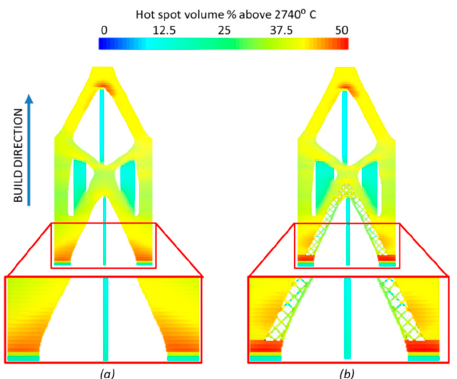
Figure 9. Comparing the hotspot observed in ( a ) the optimized domain and ( b ) the ‘X’ lattice introduced optimized domain. The inset in (a) shows the regions a ff ected by the hotspot and in (b) the e ff ect